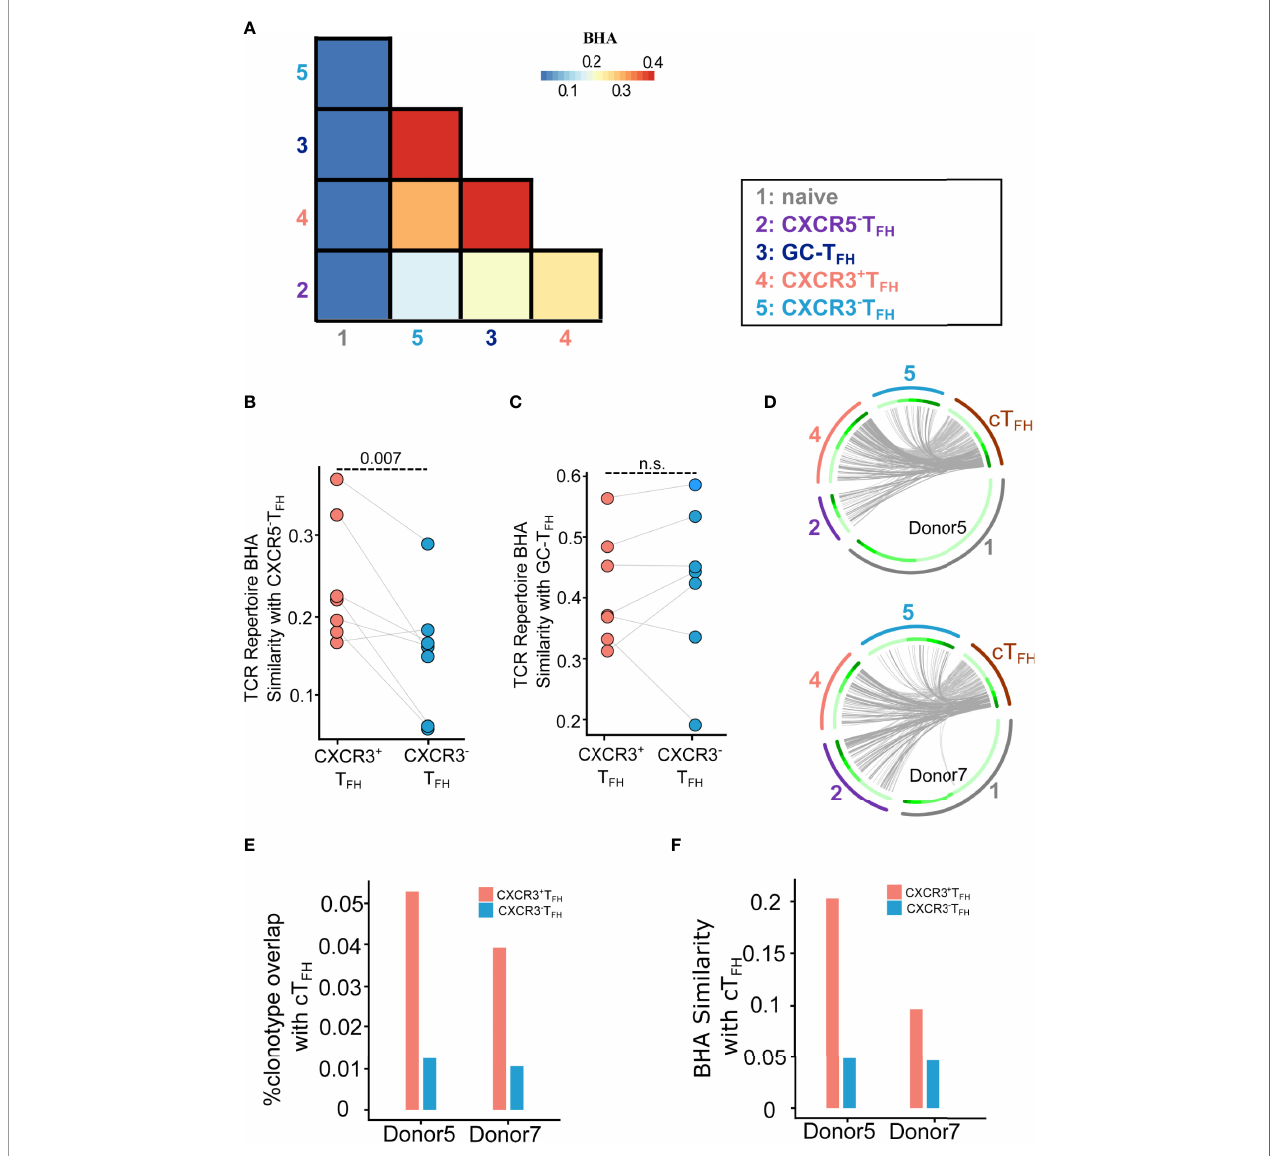
FIGURE 4 | TCR repertoire analysis demonstrates the clonal relationship of CXCR3 + T FH with the CXCR5 - T FH outside GC and cT FH in the blood. (A) Average BHA similarity among different T cell subsets. (B) Dot plot shows BHA similarity of CXCR3 + /CXCR3 - T FH with the CXCR5 - T FH population (n = 7). (C) Dot plot shows BHA similarity comparing CXCR3 + /CXCR3 - T FH with GC-T FH (n = 7); n.s.: not signi fi cant. (D) Circos plots show the overlap of cT FH TCR with LN T cell populations. Two donors were analyzed. Each small slice of the arc represents one TCR clonotype, sorted by its size (darker green for larger clones, inner circle). The gray curves link overlapping TCR nucleotide clonotypes in naïve (black, outer circle), CXCR5 - T FH (dark blue, outer circle), CXCR3 + T FH (blue, outer circle), CXCR3 - T FH (red, outer circle) and cT FH (dark green, outer circle). The most expanded 30% clonotypes were highlighted with darker gray curves. (E) Histogram plot shows percentage of TCR clonotype overlapping comparing CXCR3 + /CXCR3 - T FH with cT FH . (F) Histogram plot shows BHA similarity comparing CXCR3 + /CXCR3 - T FH with cT FH